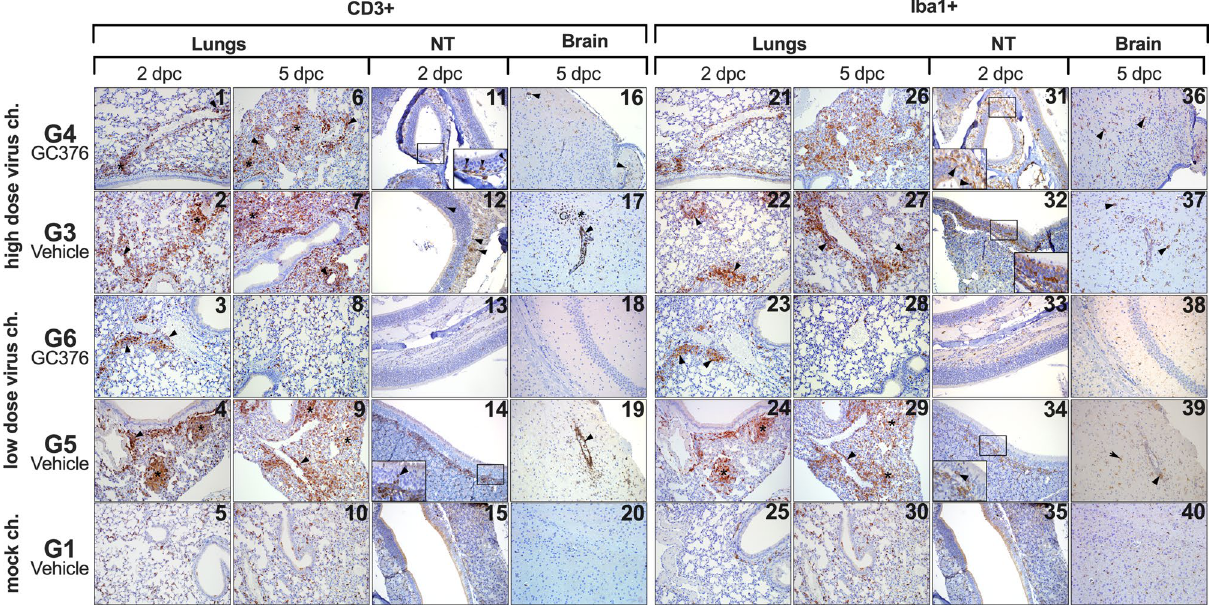
Figure 6. T-cell and monocyte/macrophages accumulation in lung, NT and brain from GC-376- and vehicle-treated mice at selected timepoints. ( 1 – 4 , 6 – 7 , 9 ) Increased numbers of T lymphocytes are expanding perivascular and peribronchiolar spaces (arrowheads) and invading the interstitium (asterisks) at 2 and 5 dpc in G4, G3, G6 and G5. In G6, 2/3 mice did not present any increase in T-cells at 5 dpc. ( 5 , 10 ) G1, normal lungs from uninfected control mice at 2 and 5 dpc, respectively. Note resident CD3+ lymphocyte concentrations in the resting tissue. ( 11 – 12 , 14 ) Mild increase in T-cells were observed in G4, G3 and G5 NT at 2 dpc invading lamina propria and olfactory epithelium (arrowheads). ( 13 , 15 ) No increase in CD3+ staining was observed in G6 and G1 NT at 2 dpc. ( 16 – 17 , 19 ) Mild-moderate increase in perivascular T-cells was observed in G4, G3, and G5 brains at 5 dpc. ( 18 , 20 ) No increase in CD3+ staining was observed in G6 and G1 brains at 5 dpc. ( 21 – 24 , 26 – 27 , 29 ) Increased numbers of Iba1+ cells were found effacing perivascular and peribronchiolar spaces (arrowheads) and invading the interstitium (asterisks) at 2 and 5 dpc in G4, G3, G6 and G5. ( 28 ) G6, 2/3 mice did not present any increase in T-cells at 5 dpc. ( 25 , 30 ) G1, normal lungs from uninfected control mice at 2 and 5 dpc, respectively. Note resident Iba1+ macrophages concentrations in the resting tissue. ( 31 – 32 , 34 ) Mild increase in macrophages were observed in G4, G3 and G5 NT at 2 dpc invading lamina propria and olfactory epithelium (arrowheads and inserts). ( 33 , 35 ) No increase in Iba1+ staining was observed in G6 and G1 NT at 2 dpc. ( 36 – 37 , 39 ) Mild-moderate increase in perivascular macrophages was observed in G4, G3, and G5 brains at 5 dpc accompanied by marked increased in staining of resident microglial cells within areas of intense virus antigen positivity (arrowheads). ( 38 , 40 ) No increase in Iba1+ staining was observed in G6 and G1 brains at 5 dpc. Pictures and inserts were taken at 20 × and 40 × magnification,